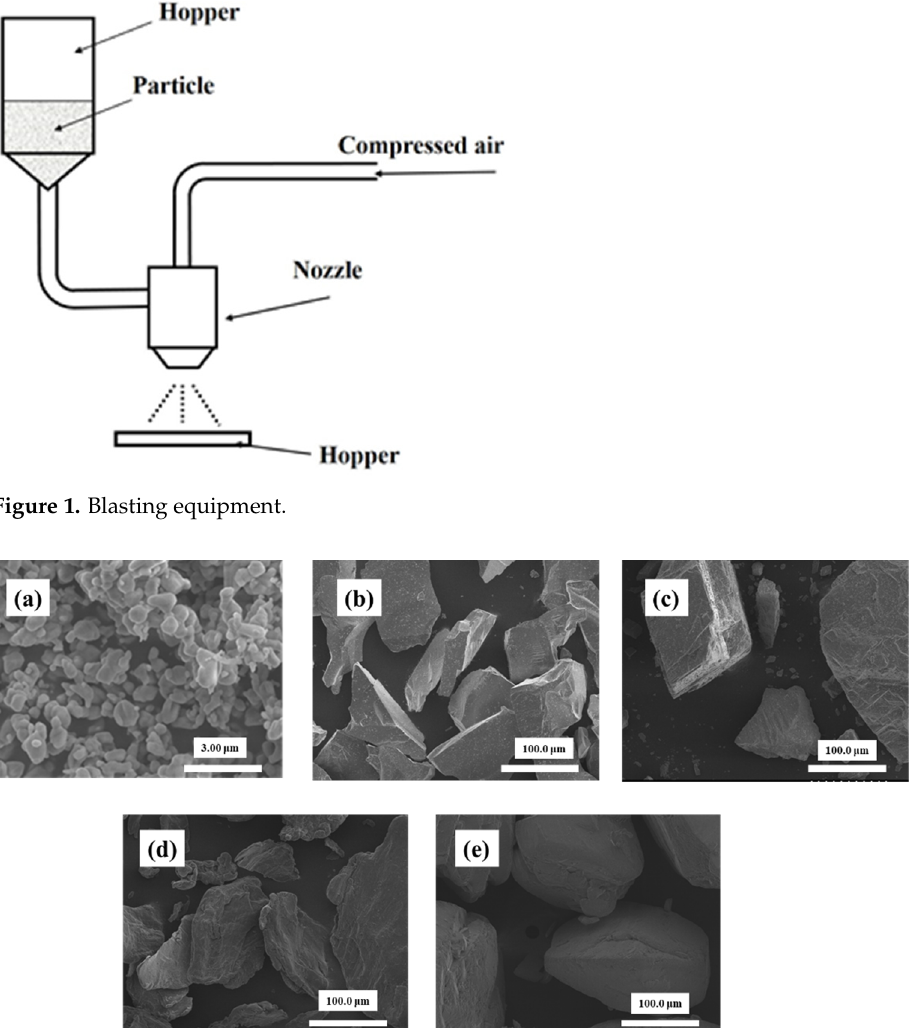
Figure 2. SEM images of particles. The particles used in this study were: β -TCP particles ( a ), white alumina particles ( b ), calcium carbonate particles ( c ), agar particles ( d ), and glycine particles ( e ).